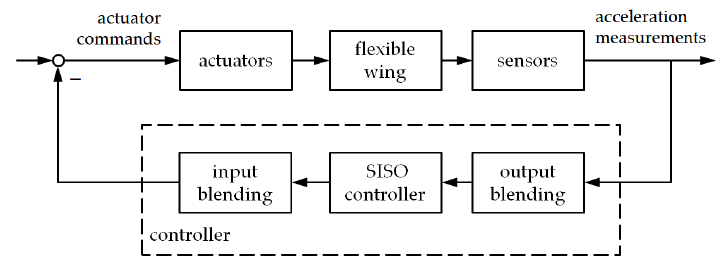
Figure 13. Control loop interconnection.